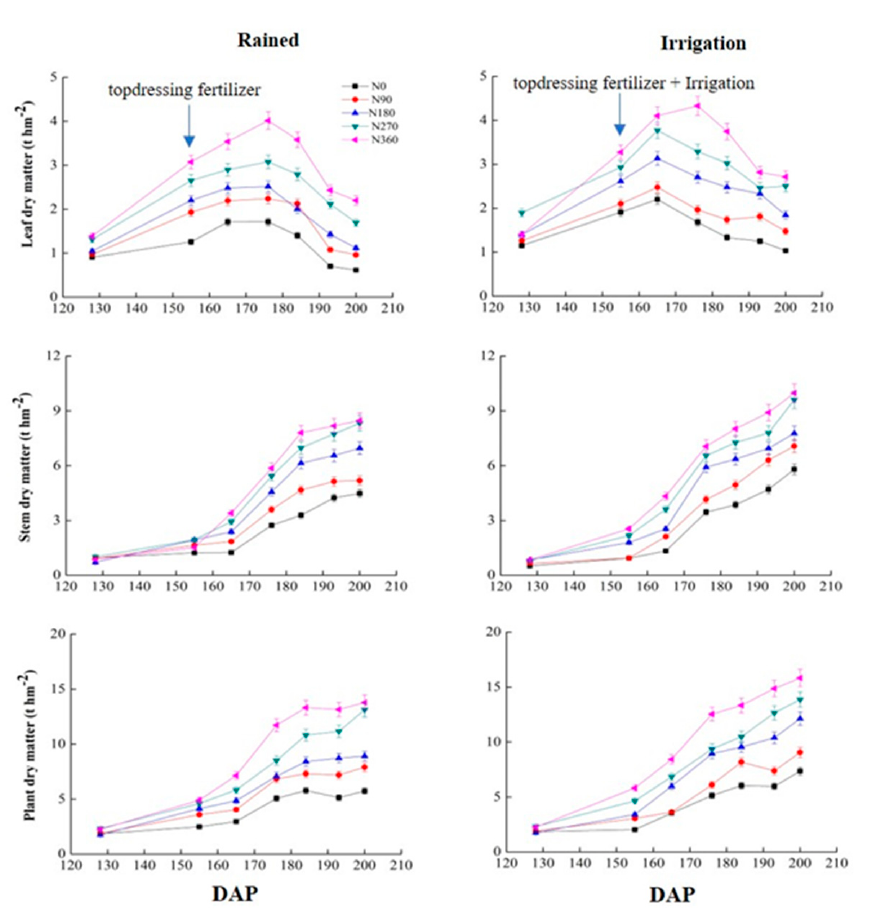
Figure 1. E ff ects of N application rates on wheat dry matter under di ff erent irrigation. DAP: days after Figure 1. Effects of N application rates on wheat dry matter under different irrigation. DAP: days planting. The datasets are from Exp. after planting. The datasets are from Exp. 2.